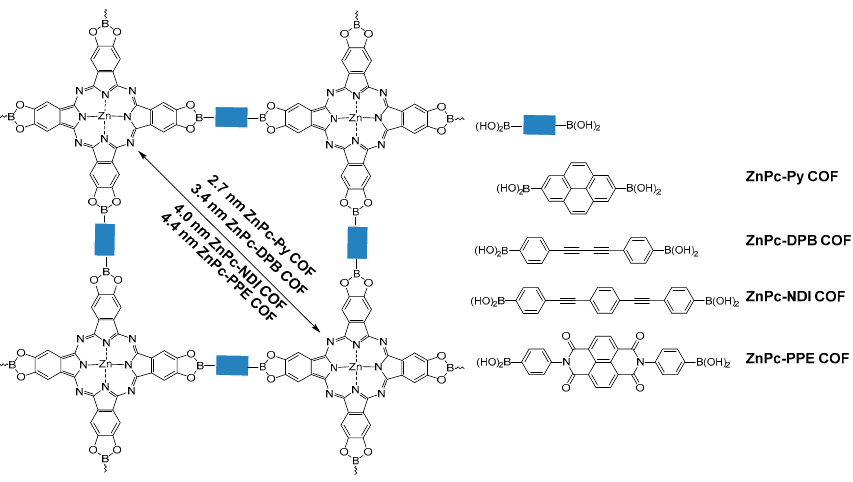
Figure 5. Construction of dioxaborole-linked COFs via the cross-condensation of ditopic catechol- based linkers with tritopic boronic acids to form 2D honeycomb layer structures. The pore sizes can be modulated by the decorated functionalities of the ditopic linkers, and expanded by elongating both the boronic acid and catechol linkers.